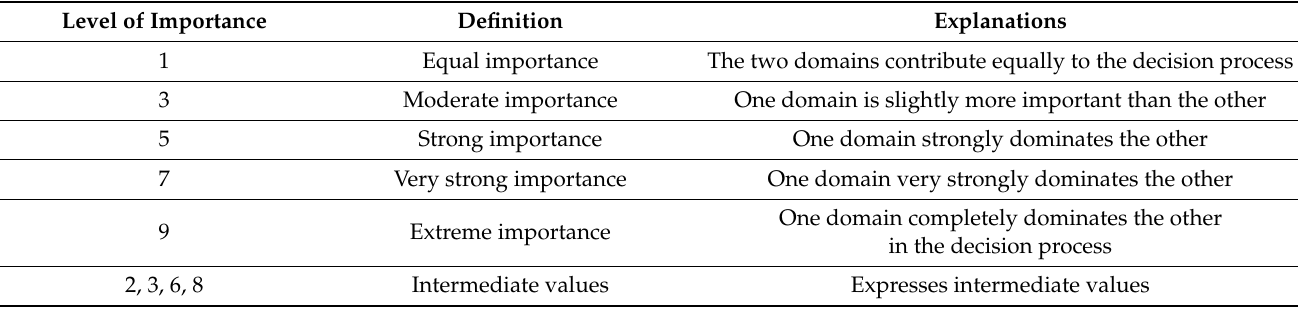
Table 3. Pairwise comparison